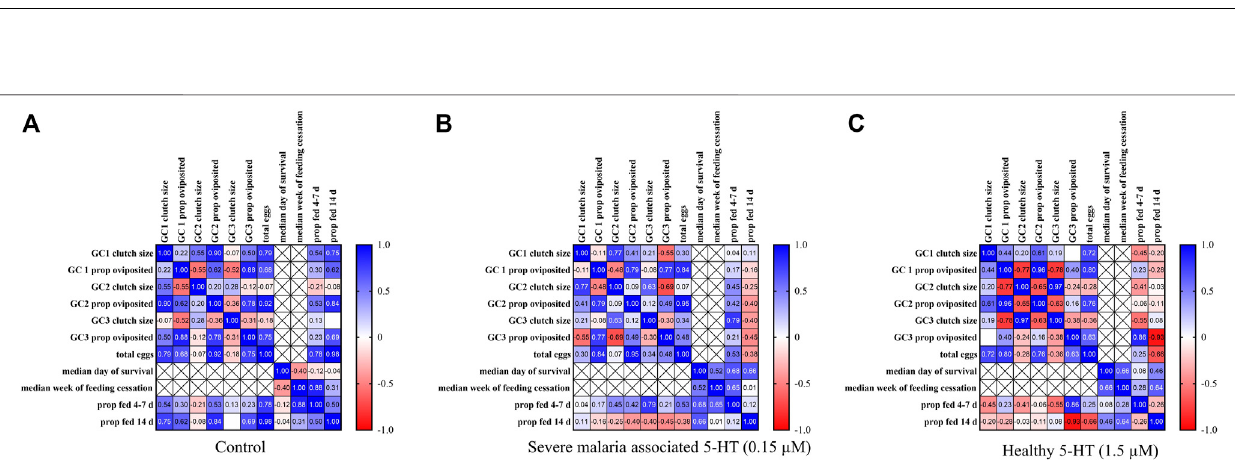
FIGURE4| Tendencyofuninfected A.stephensi totakeasecondbloodmeal14 days later. (A) Numbersoffedandunfed uninfectedmosquitoesprovisionedwith 5-HT in the fi rst bloodmeal and (B) data from (A) shown as percentages of fed and unfed mosquitoes provisioned with 5-HT in the fi rst bloodmeal in each group. N = 5; Chi-squared test ( α = 0.05), no signi fi cance. (C) Numbers of fed and unfed uninfected mosquitoes following priming for 3 days with 5-HT in water or water only soaked cotton balls and (D) data from (C) shown as percentages of fed and unfed 5-HT primed mosquitoes in each group. N = 5; Chi-squared test ( α = 0.05), no signi fi cance.